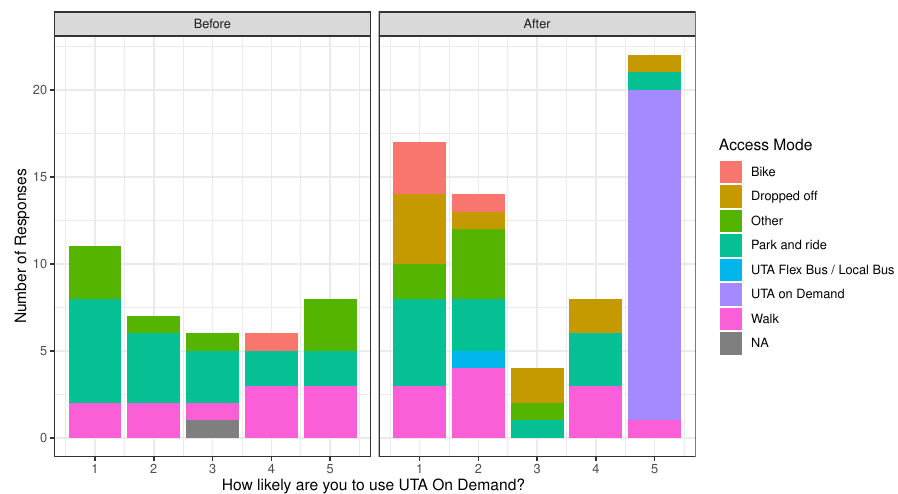
Figure 2. Reported likelihood of using microtransit by transit access